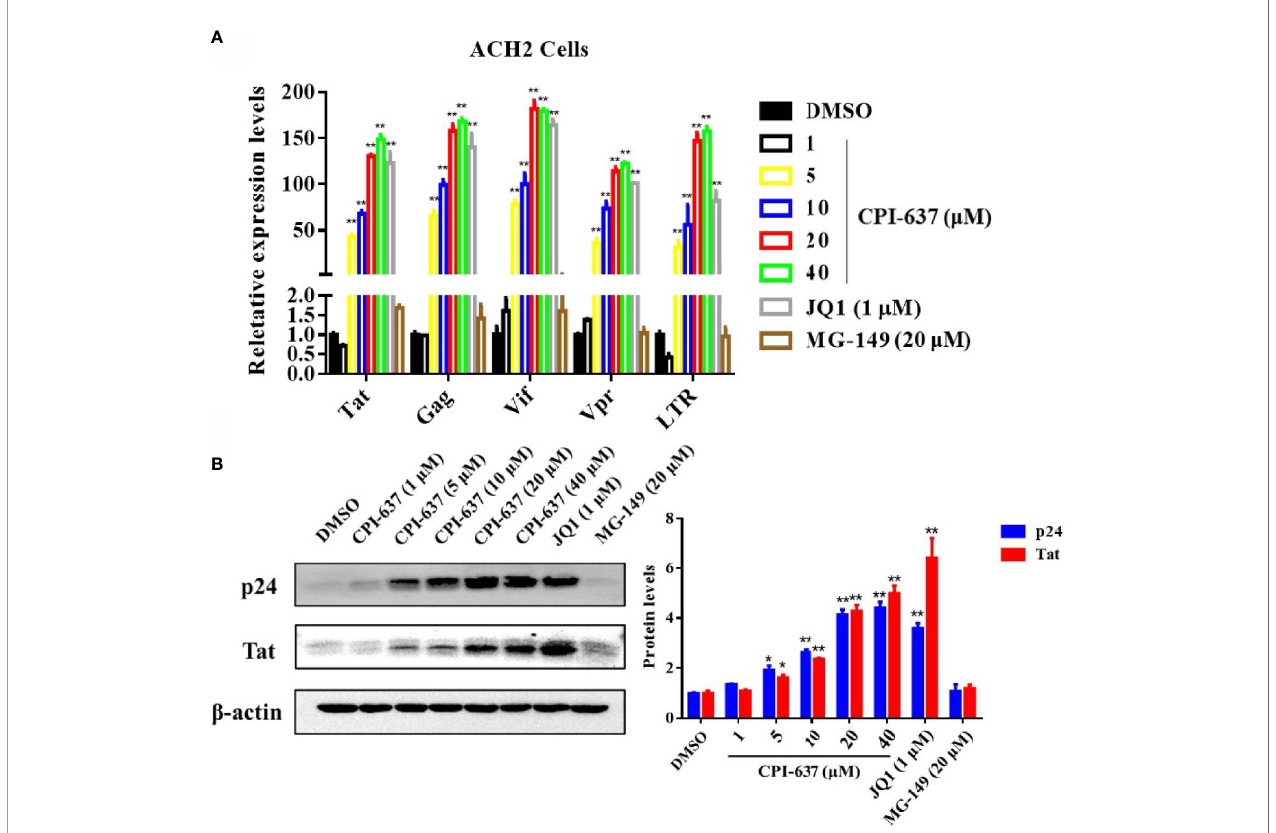
FIGURE 2 | CPI-637 increases the HIV-1 transcriptional gene and core protein expression in vitro . ACH2 cells were treated with CPI-637 at the indicated concentrations for 48 h. HIV-1 RNA levels were analyzed by RT-qPCR (A) . The relative expression levels were compared to those in DMSO control group. The expression levels of Tat and p24 proteins were analyzed by WB (B) , and the quanti fi cations of Tat and p24 were also performed in (B) (* p < 0.05 vs DMSO control group, ** p < 0.01 vs DMSO control